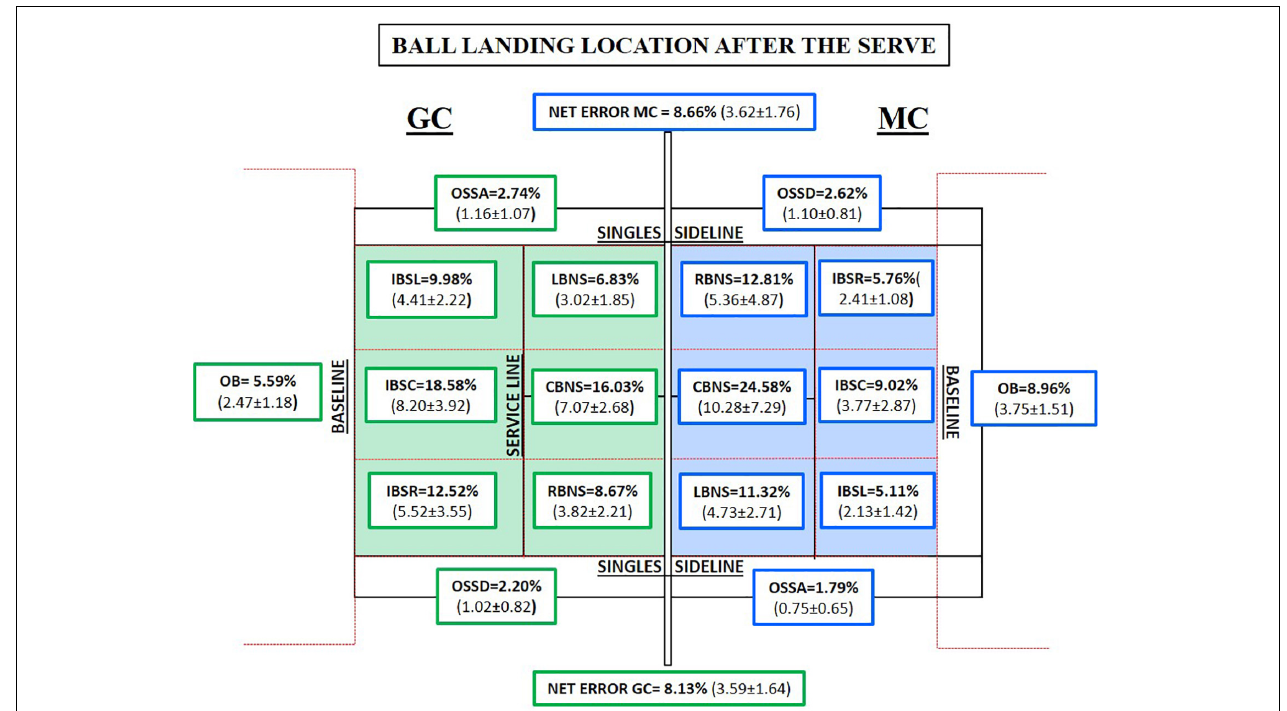
FIGURE 5 | Percentage and mean per match of ball landing locations after the serve per match in both competitions (Tennis 10s Green Competition “GC” = green color and Modified Competition “MC” = blue color). IBSR, inside the court behind the service line in the right area; IBSC, inside the court behind the service line in the central area; IBSL, inside the court behind the service line in the right area; RBNS, the right area between the net and the service line; CBNS, the central area between the net and the service line; LBNS, the left area between the net and the service line; OSSD, out from the singles sideline on the deuce side; OSSA, out from the singles sideline on the advantage